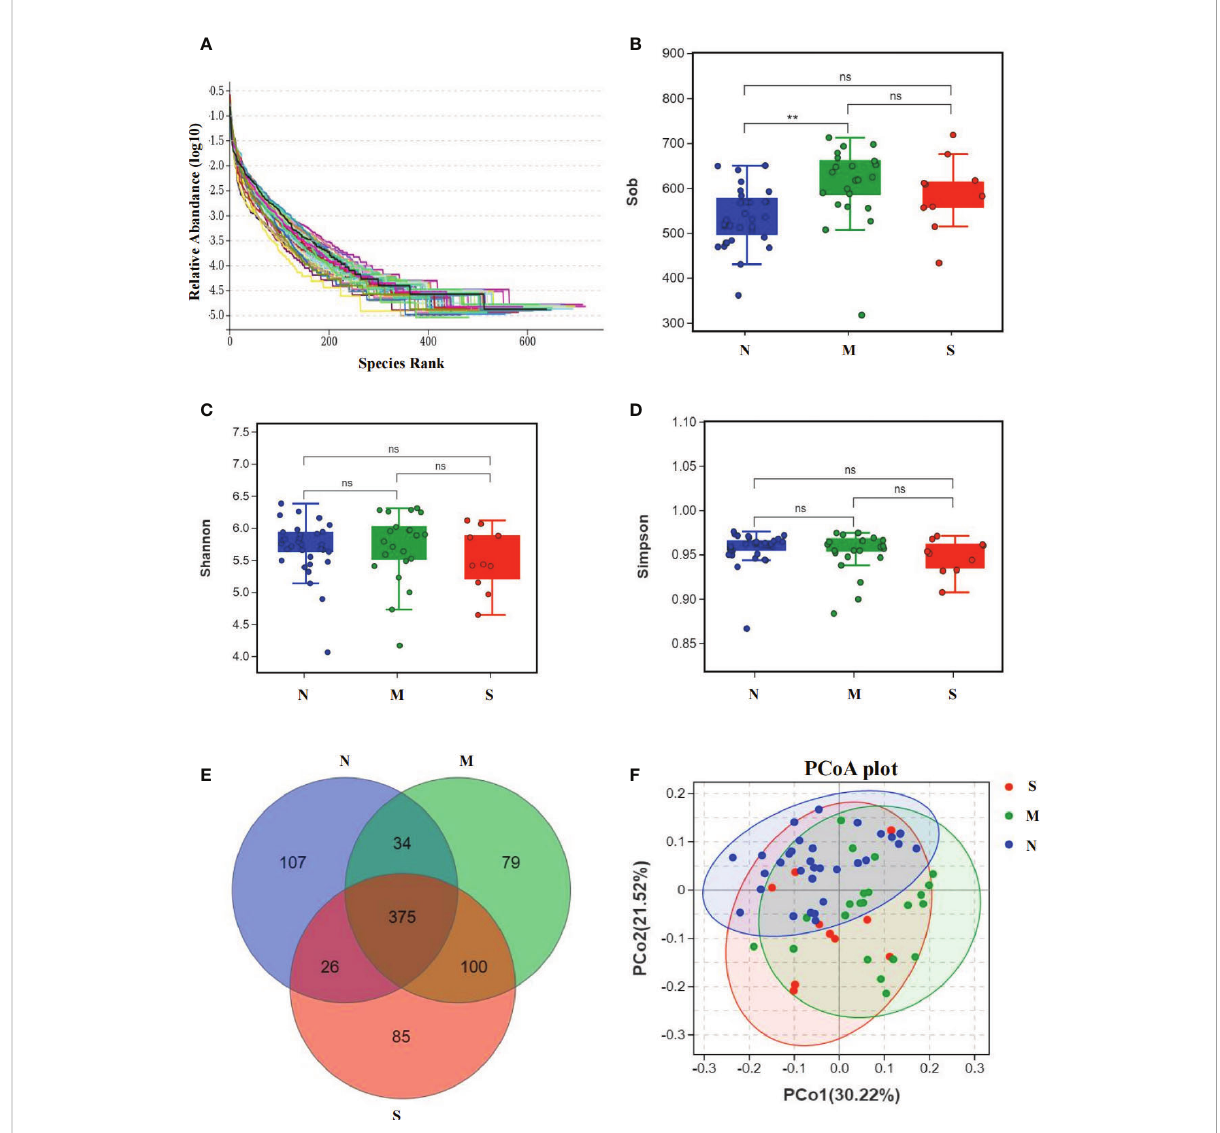
FIGURE 2 Bacterial diversity of the oral microbiota collected from nasopharyngeal carcinoma patients. (A) The relative bacterial evenness of each sample was evaluated by the rank abundance curves. (B-D) a -diversity of oral microbial were estimated by the Sob index, Shannon index and Simpson index. Turkey-HSD analysis was used. ** = p value < 0.01, ns = no signi fi cant difference. (E) The Venn diagram displayed the overlaps between all three groups based on OTUs level. (F) b -diversity was calculated using weighted UniFrac by PCoA plot. Kru-Wall test was used, and p